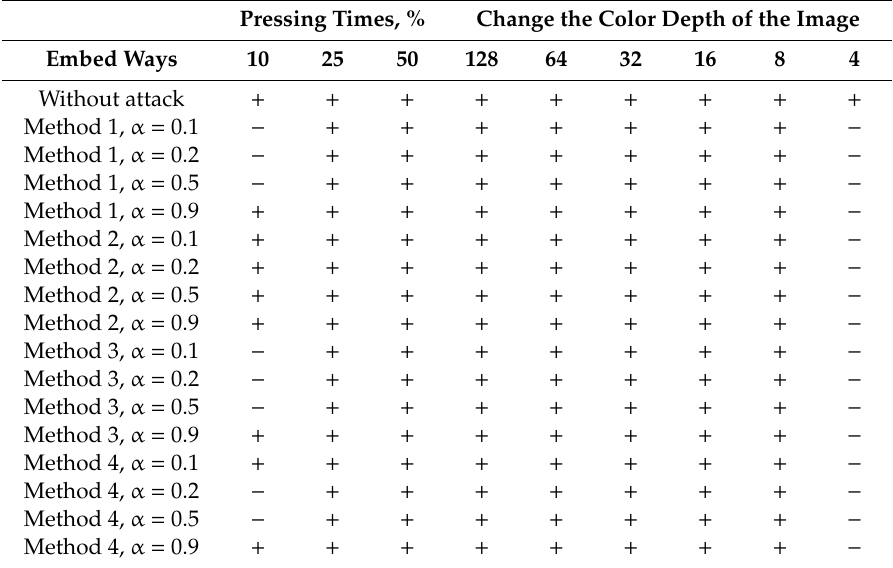
Table 2. The results of the experiments carried out on the attacks to verify the e ff ectiveness of the method on the example of the test image “Lena” by Equation (34) for the parameters m = 1, n = 7. Pressing Times, % Change the Color Depth of the Image